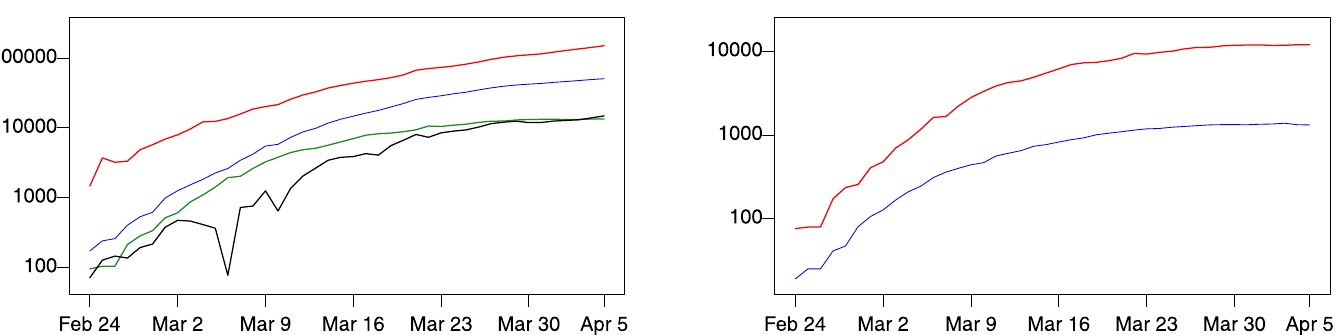
Fig 1. Lombardy data, February 24, 2020 to April 5, 2020. Left: Number of hospitalized patients (green), home-quarantined (black), tested (red), infected (blue). Right: Patients hospitalized with symptoms (red, HwS ) and admitted in ICU (blue, IC ). Both vertical axes are logarithmic, with successive ticks corresponding to increasing powers of